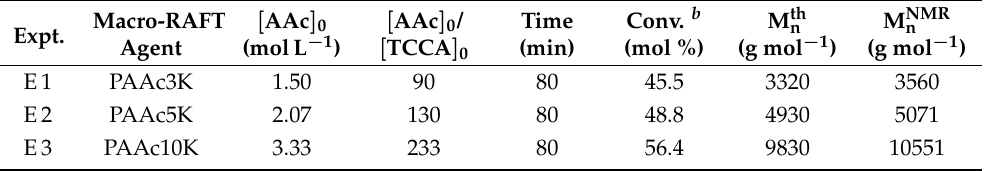
Table 1. Composition, experimental conditions, and analysis of the synthesised macro-RAFT agents PAAc-TTC in 1,4-dioxane and their molecular characteristics a .